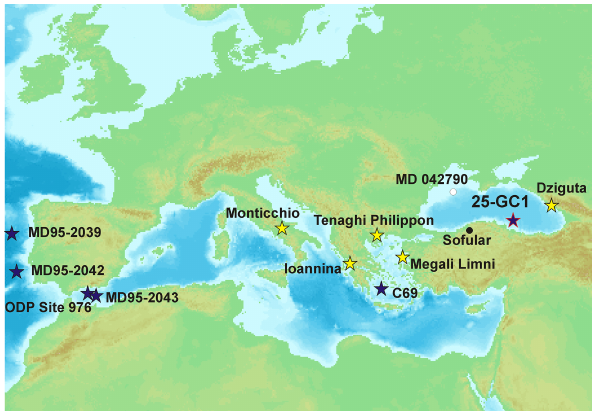
Fig. 1. Location of the Black Sea core 25-GC1 and records covering the last glacial as discussed in the text: stalagmites (black dot) – So- fular Cave (Fleitmann et al., 2009; Badertscher et al., 2011); TEX 86 temperature reconstructions (white dot) – MD042790 (Ménot and Bard, 2012); terrestrial pollen records (yellow stars) – Dziguta (Arslanov et al., 2007), Ioannina (Tzedakis et al., 2004), Megali Limni (Margari et al., 2009), Monticchio (Allen et al., 1999, 2000), and Tenaghi Philippon (Müller et al., 2011); marine pollen records (blue stars) – C69 (Geraga et al., 2005), MD95-2039 (Roucoux et al., 2005), MD95-2042 (Sánchez Goñi et al., 2000), MD95-2043 (Sánchez Goñi et al., 2002), OPD Site 976 (Combourieu-Nebout et al.,